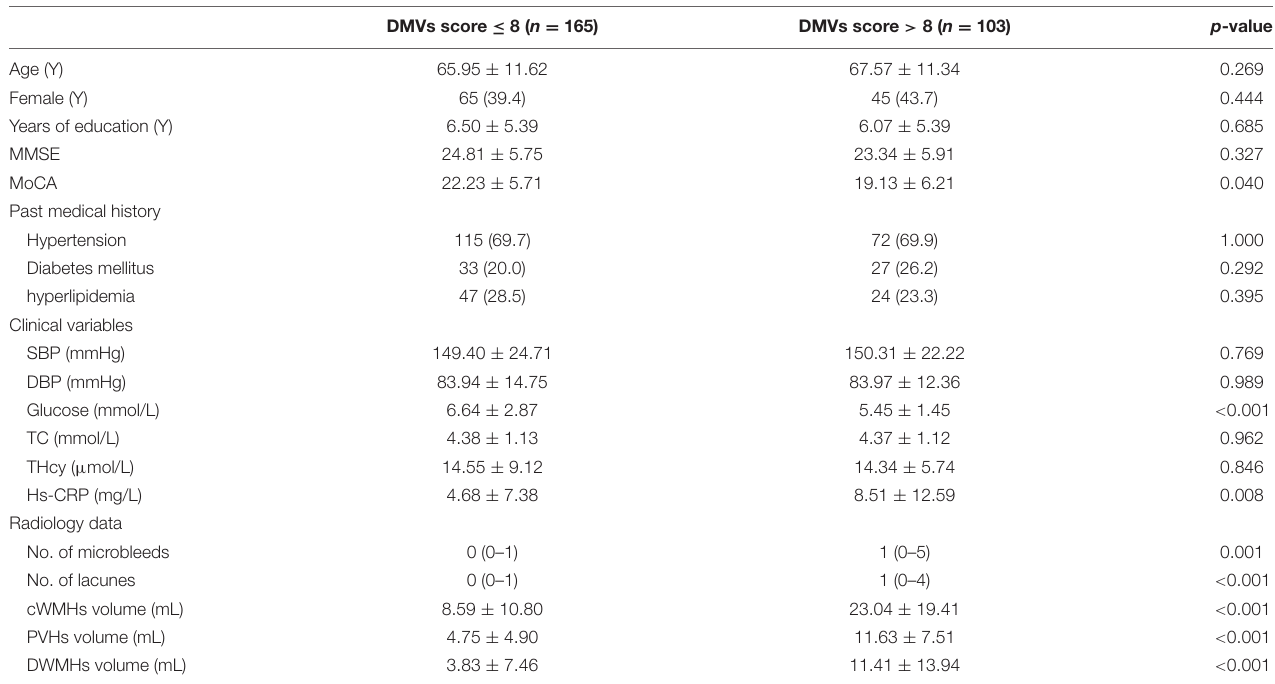
TABLE 2 | Basic data in different DMVs score